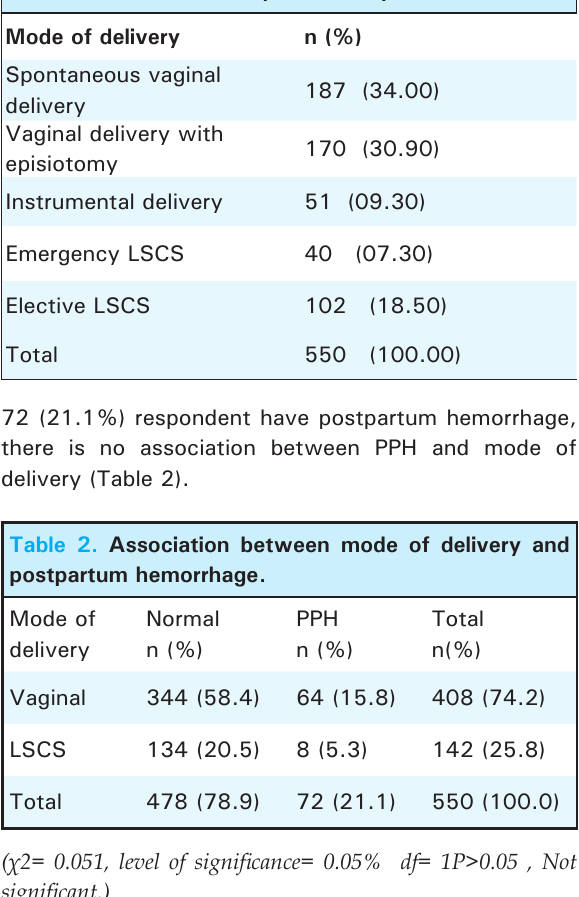
Table 1. Mode of delivery of the respondent.